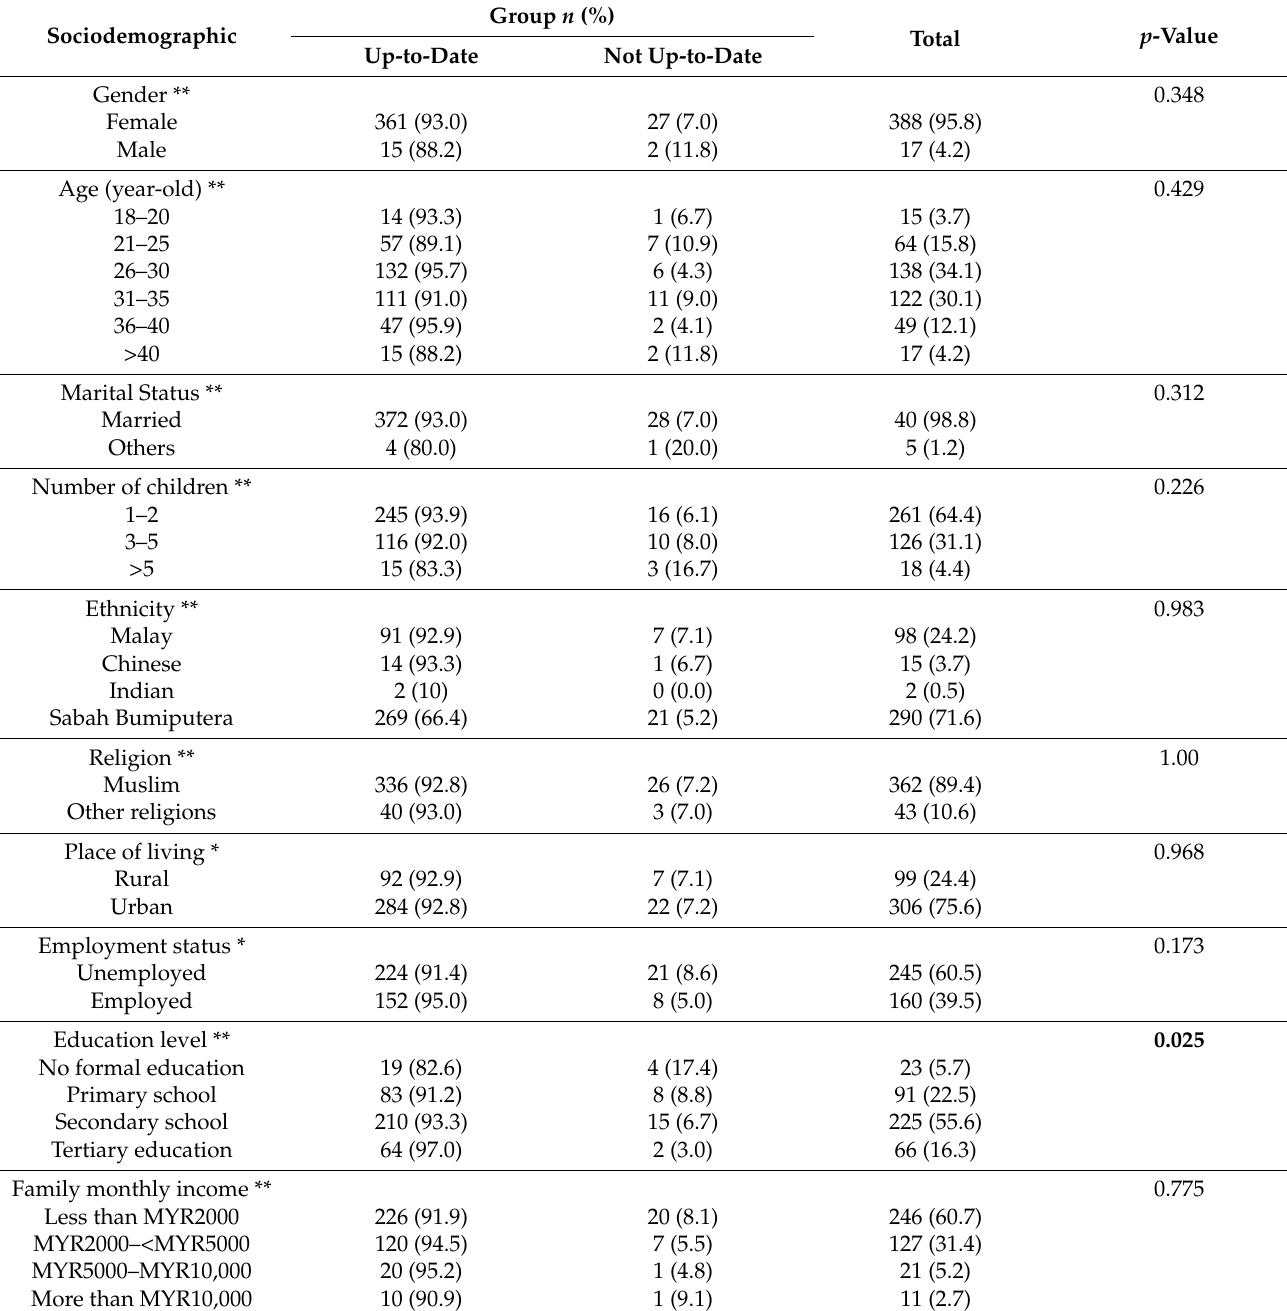
Table 3. Association between Parents’ Socio-demographic Characteristics and Children’s Immunization